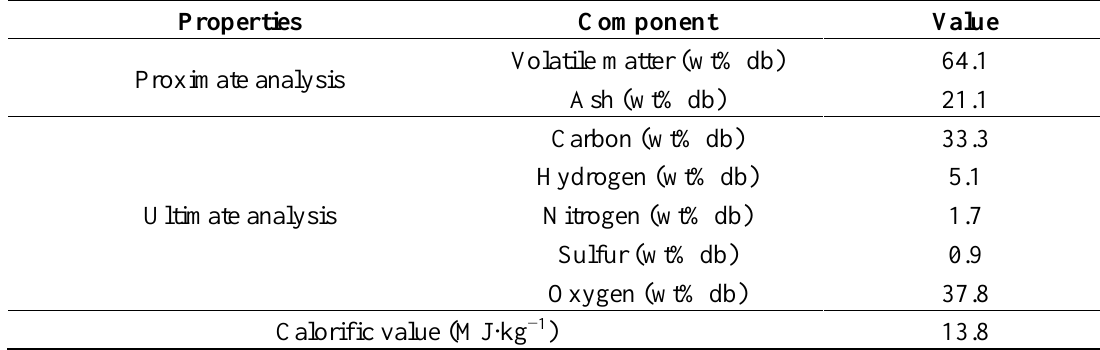
1. Proximate and ultimate analyses of Laminaria digitata